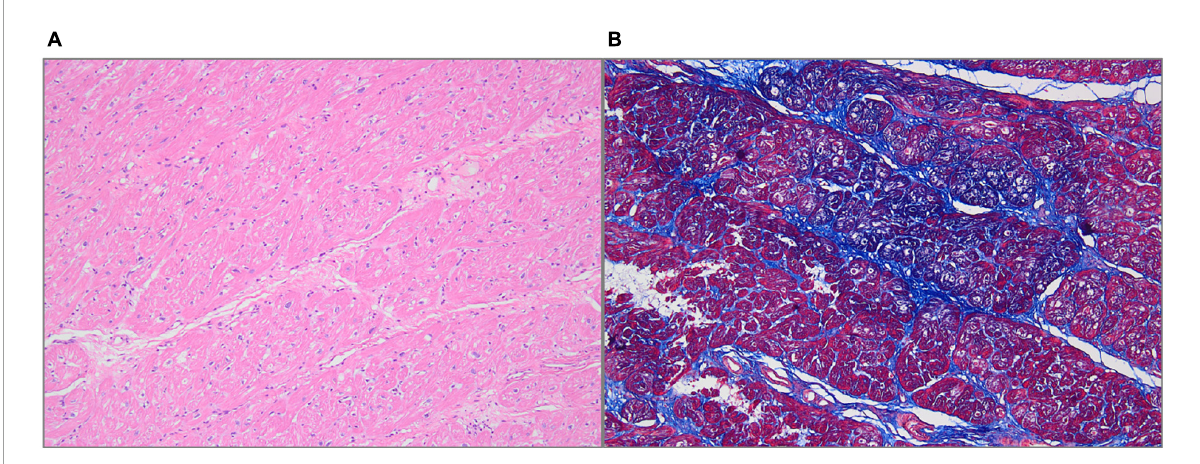
FIGURE4 Histologic features. (A) Hematoxylin-Eosin staining showed myocardial fiber hypertrophy, degeneration and necrosis of some myocardial fibers, and hyaline degeneration (100 × magnification). (B) Masson staining showed fibrous tissue hyperplasia (100 ×